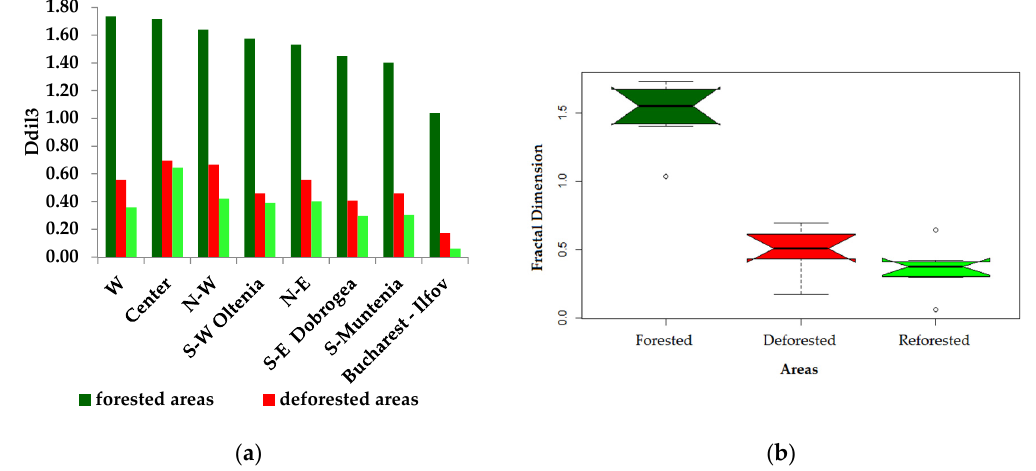
Figure 5. ( a ) D dil3 of forested, deforested and reforested areas from development regions of Romania. ( b ) Boxplots with notches represent the median, interquartile range and extreme values of D dil3 of forested, deforested and reforested areas from Romanian DRs.